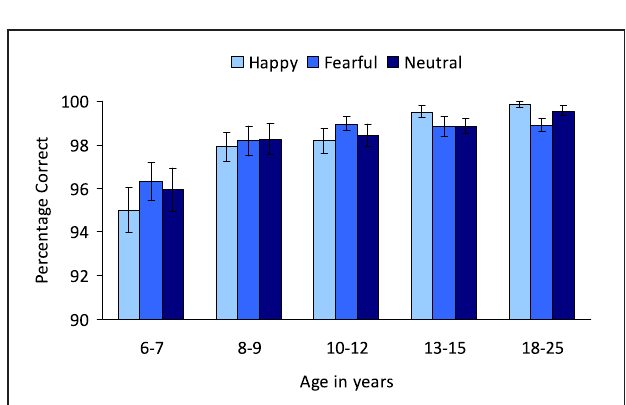
FIGURE 5 | Percentage correct on the colored emotional go/nogo task. Participants were instructed to respond to colors and emotion was an irrelevant dimension.